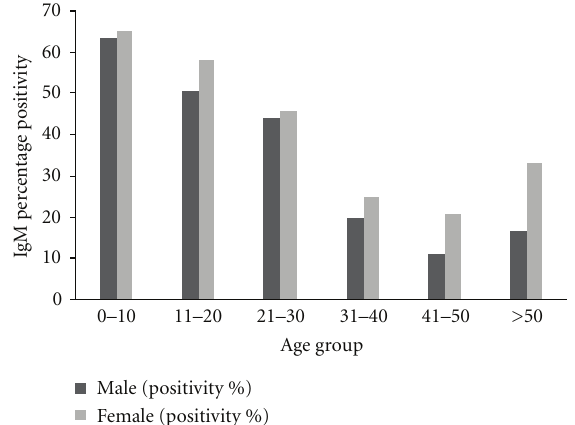
Figure 1: Age and sex wise distribution of dengue IgM-positive cases in 2010.